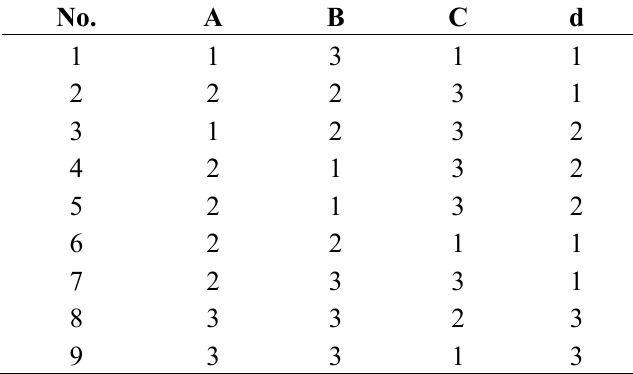
Table 2. Continuous values are changed into discrete information by using the equivalent width